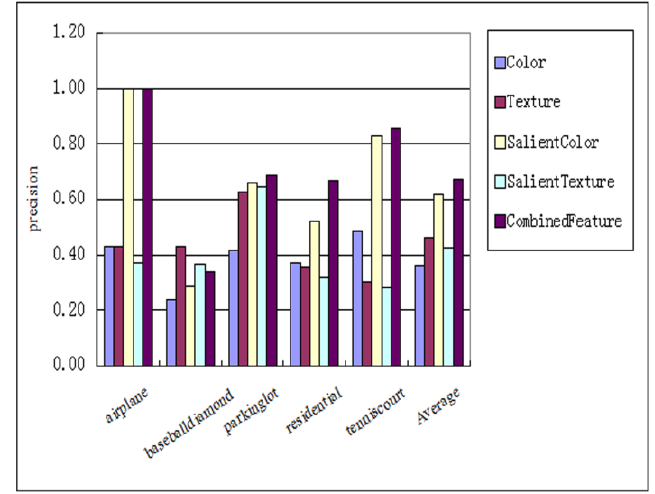
Figure5. Comparisons of prosed method with other